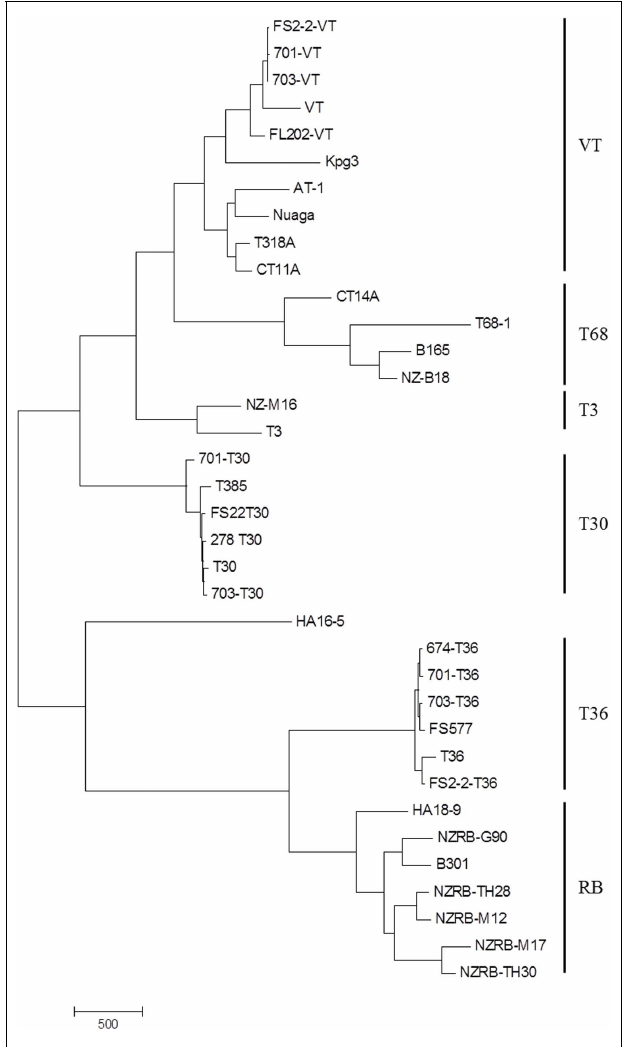
FIGURE 1 | Maximum parsimony phylogeny of the complete genomes of Citrus tristeza virus isolates examined in this study . Major strains are